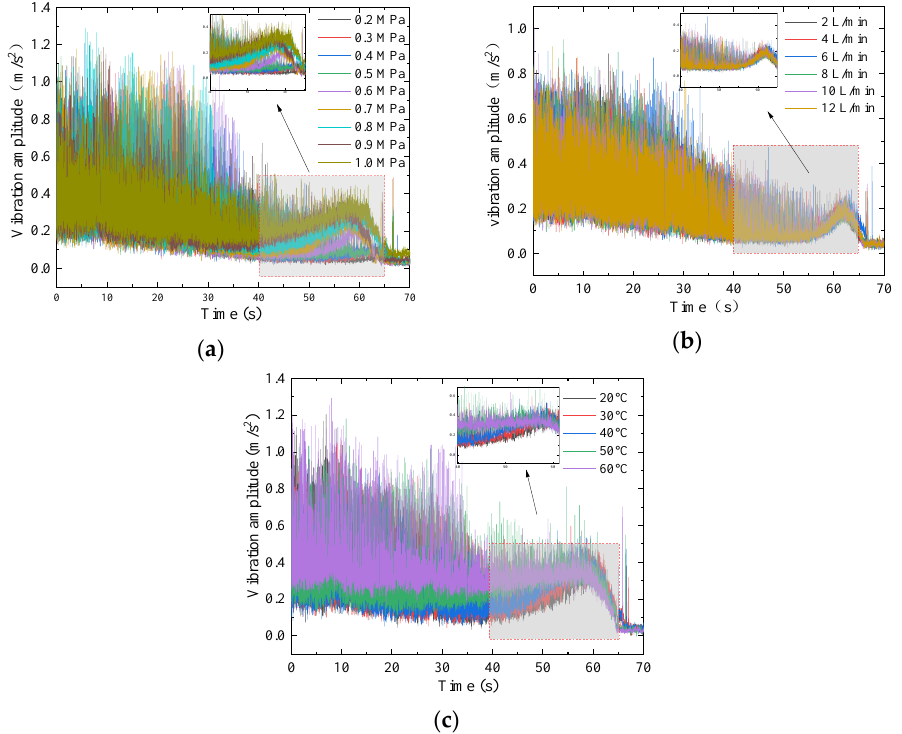
Figure 13. Time-domain diagram of the test factor for the Y direction of the test bearing. ( a ) Specific pressure, ( b ) flow rate, ( c ) temperature.